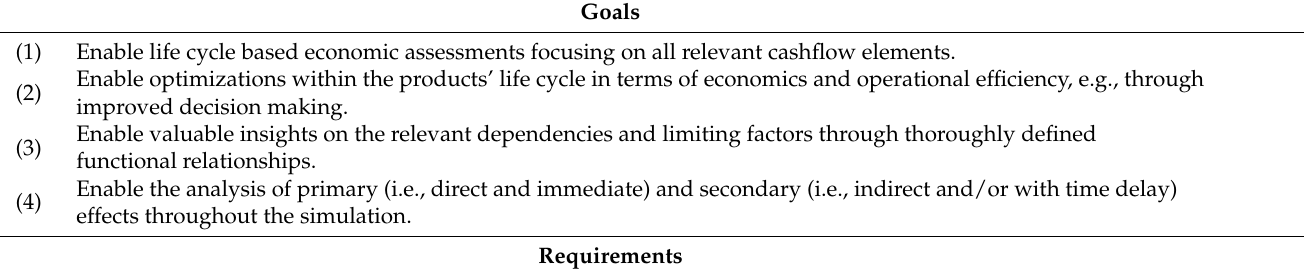
Table 2. Top level goals, requirements, and scope of